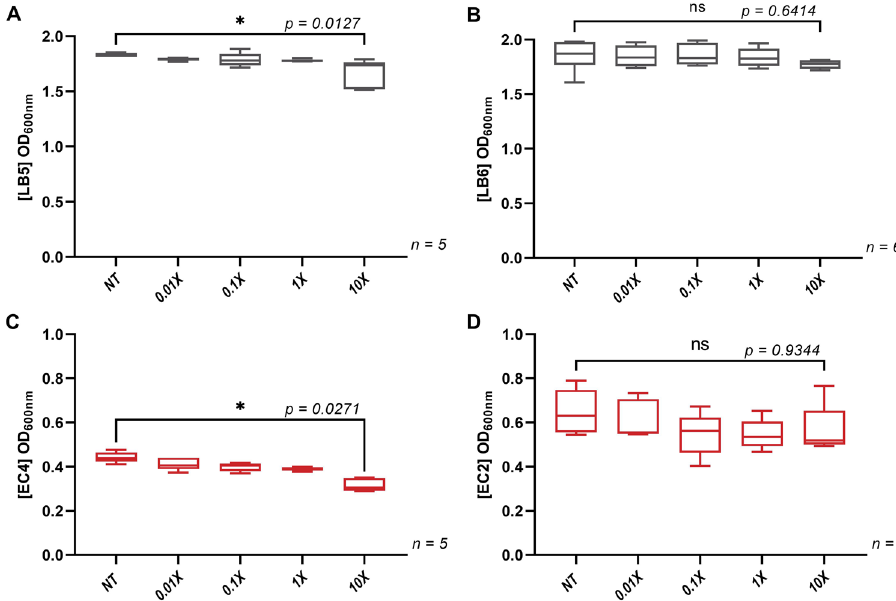
Fig. 4 Effects of the pesticide mixture on L. rhamnosus and E. coli in vitro. Bacterial growth of the strain L. rhamnosus (LB5) ( A ) is inhibited after an exposure at ten times the ADI (10×) for the mixture, while another strain of L. rhamnosus (LB6) ( B ) was not inhibited at the same dose. Similarly, E. coli (EC4) growth ( C ) was inhibited at lower doses in comparison with the other E. coli strain (EC2) ( D